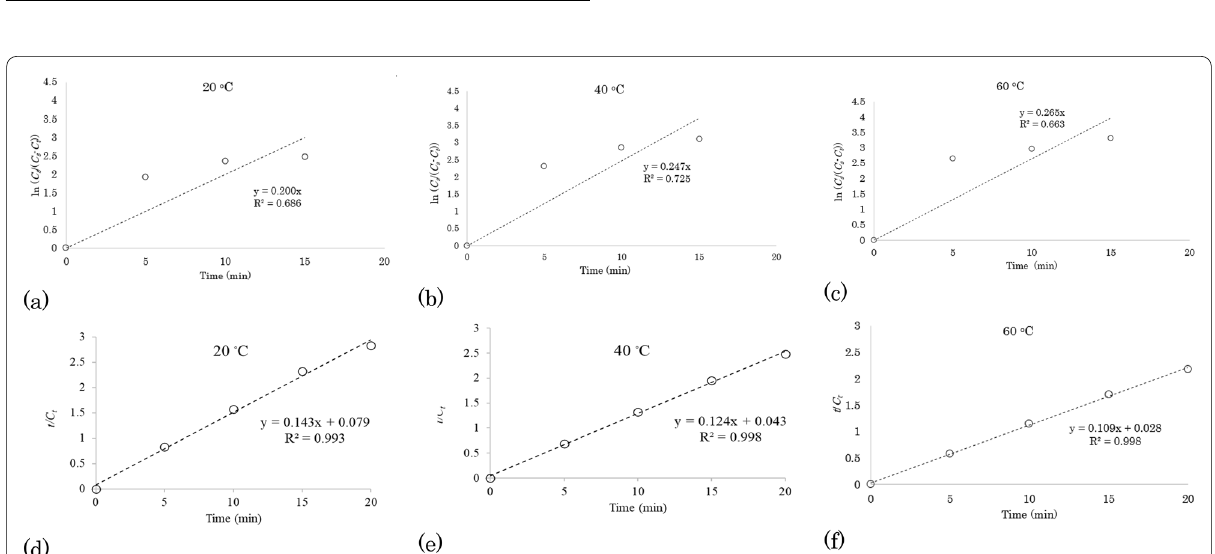
Fig. 2 First-order kinetic models ( a – c ) and second-order kinetic models ( d – f ) of extraction of total polyphenolic compounds from waste apple pomace using 50% ethanol–50% water v/v at different